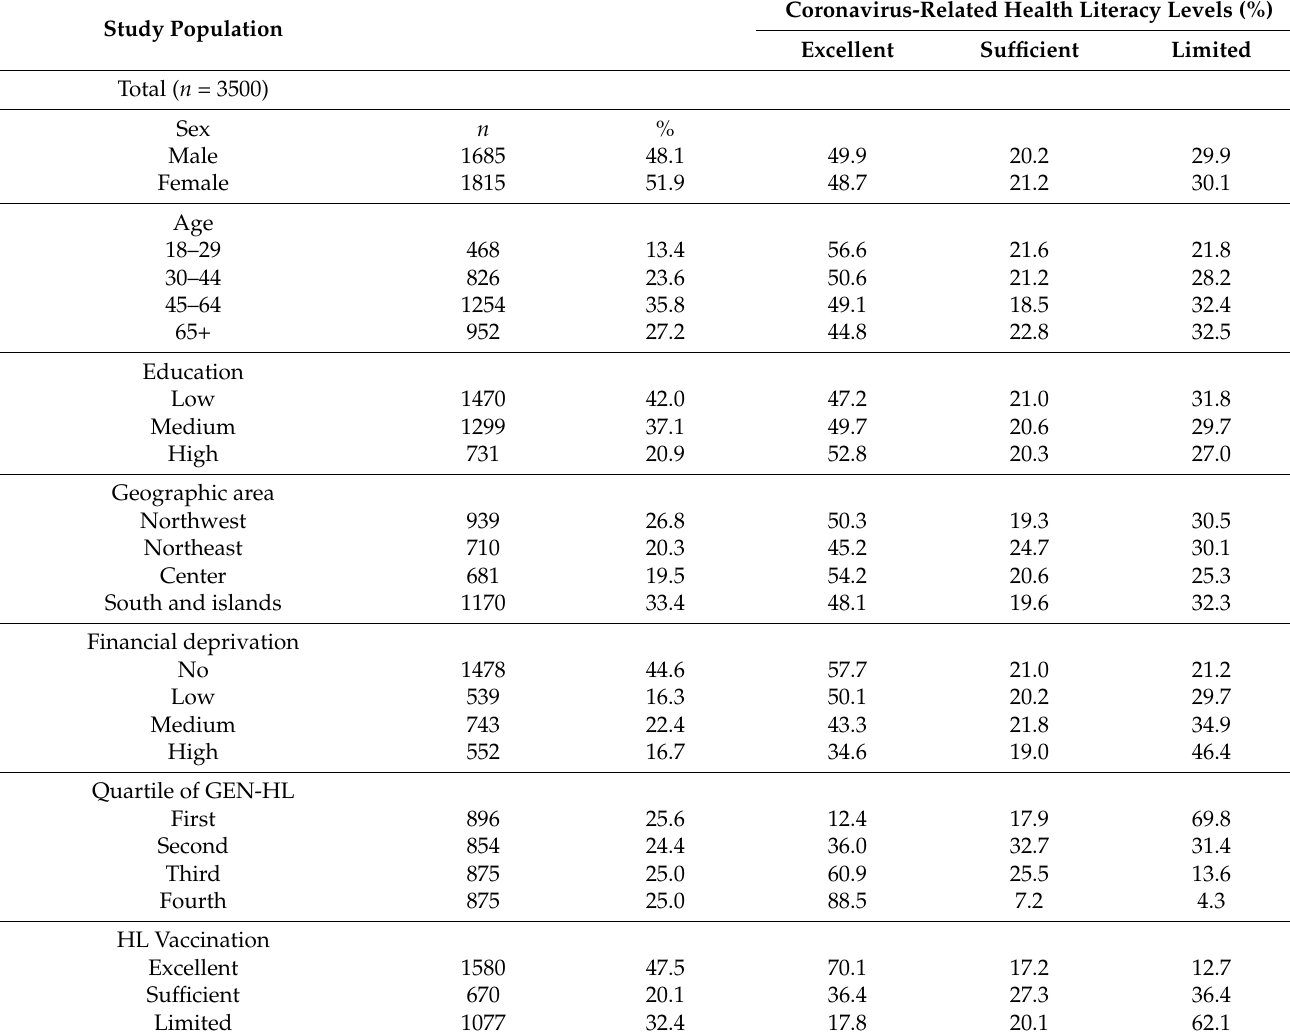
Table 3. HL-COVID levels by participants’ sociodemographic